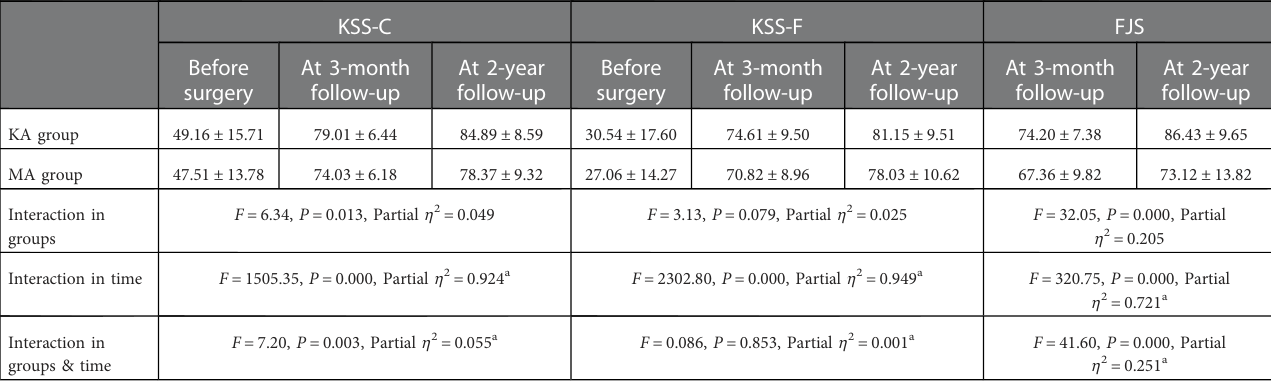
TABLE 2 Comparison of postoperative data between patients in the KA-TKA and MA-TKA groups (mean ±